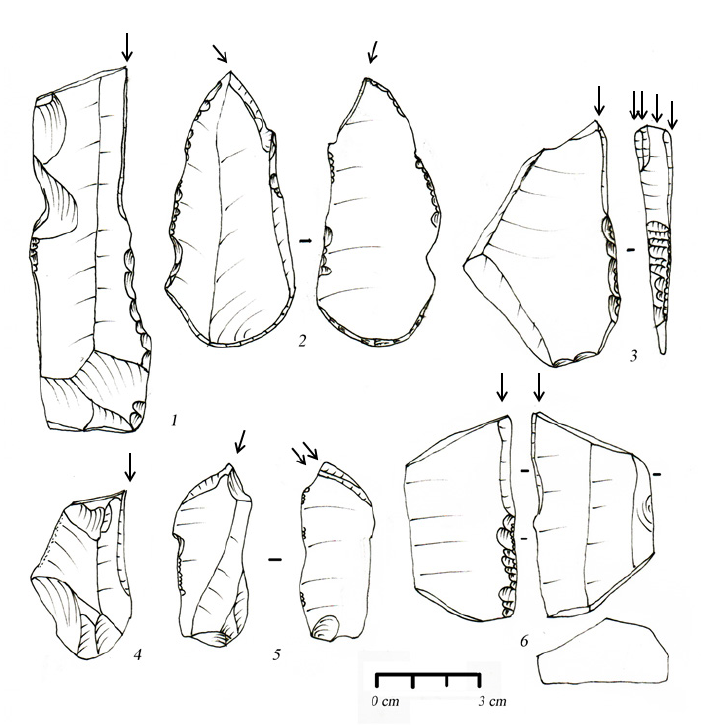
Figure 7. Lipari, Contrada Diana trench XVII. Drawing tools: 1) burins (1–6) (drawings M.C. Martinelli).